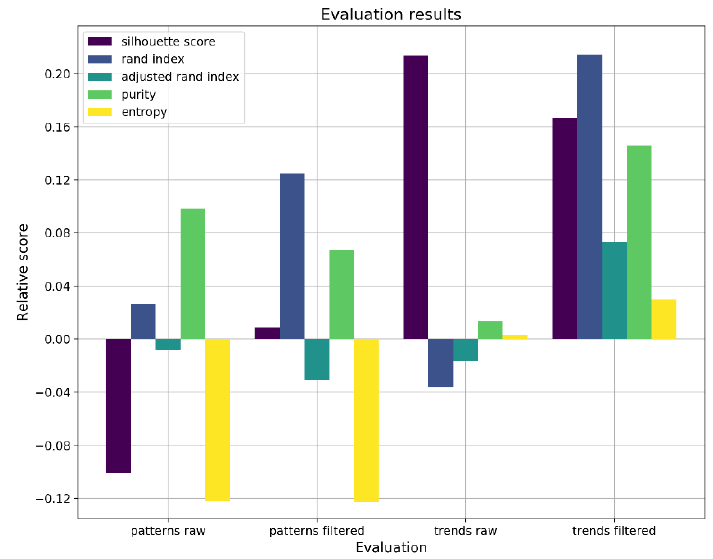
Figure 6. The consumption profile evaluation results.